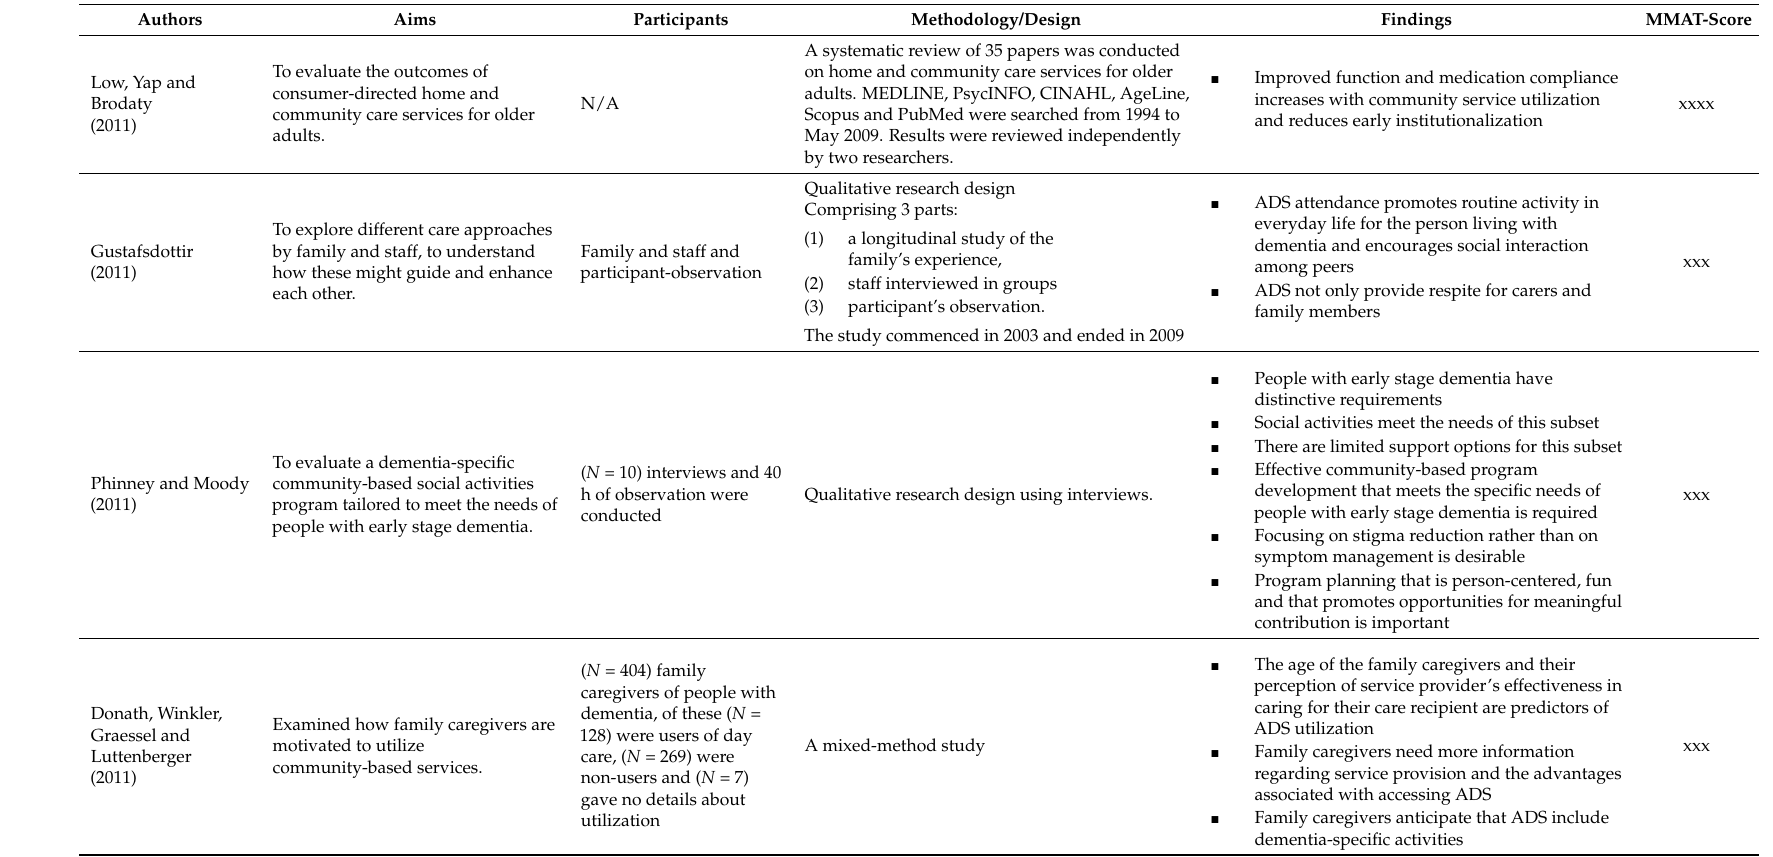
Table 1. Summary of studies included in the integrative